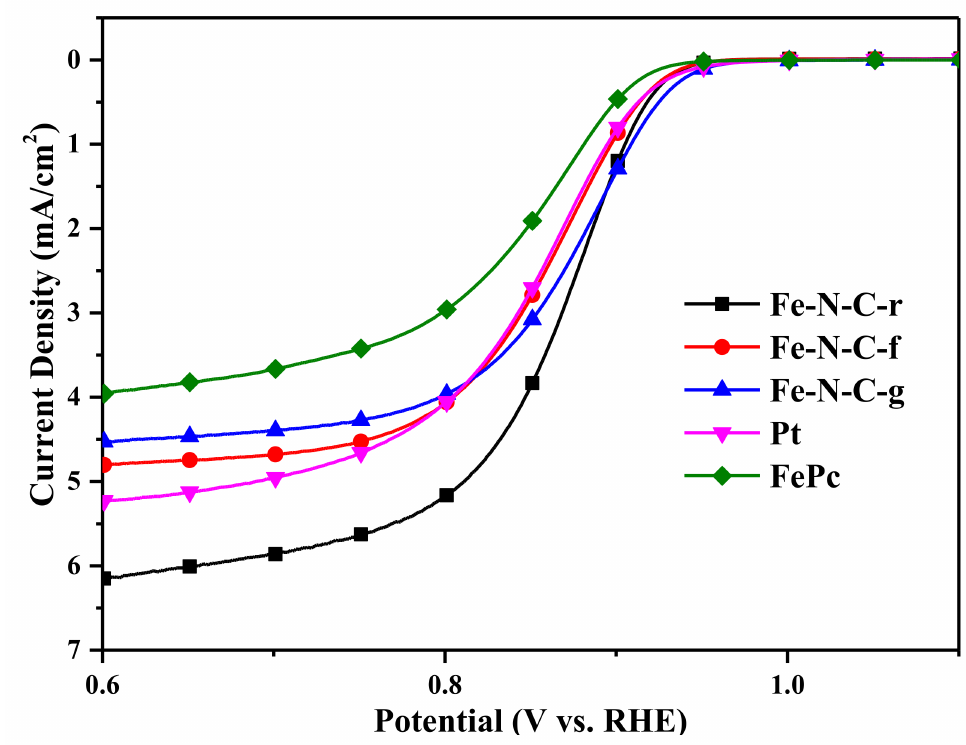
Figure 7. Linear scan voltammetry (LSV) curves of the catalysts with different morphologies, com- mercial Pt/C catalyst, and FePc powders in O 2 -saturated 0.1 M KOH